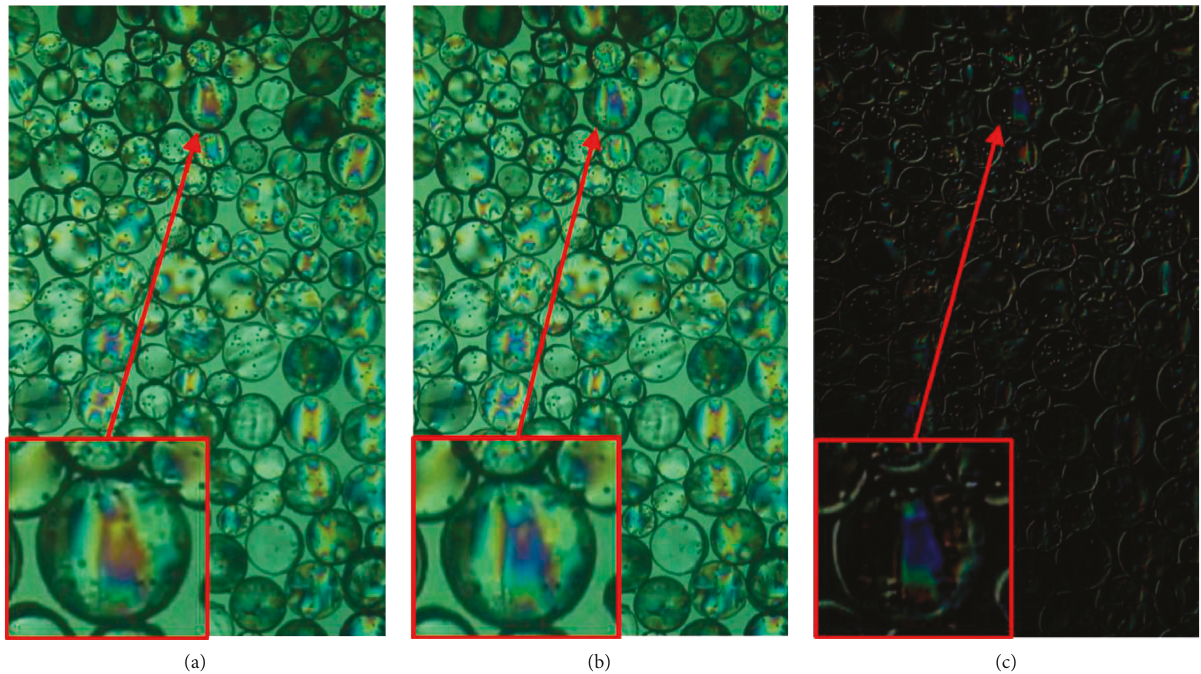
Figure 8: An example of rheological behaviors of the bonded particles under the load weight of 0.5 kg: (a) 10s, (b) 20s, and (c) the difference between figures at 10s and 20 s.